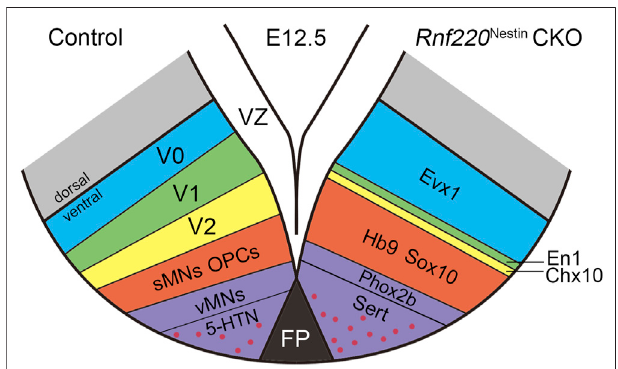
FIGURE 7 | Diagram Showing the Changes of Post-mitotic Cells in the Ventral Hindbrain of Rnf220 Nestin CKO Embryos at E12.5. The loss of Rnf220 leads to the expansion of the Evx1 + V0, Hb9 + sMNs and Sox10 + OPCs domains, whereas the En1 + V1 and Chx10 + V2 domains are reduced. Within the domain differentiated from p3, the Phox2b + vMNs domain decreases slightly but the number of 5-HTNs is